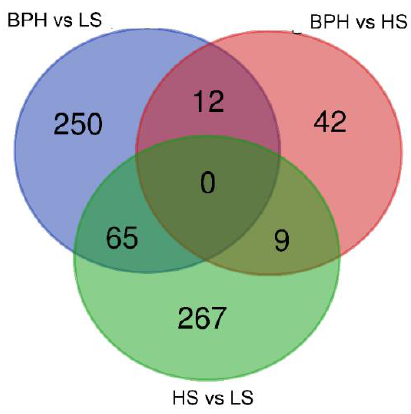
Figure 1. Venn diagram of differentially expressed genes showing overlap between different groupings.